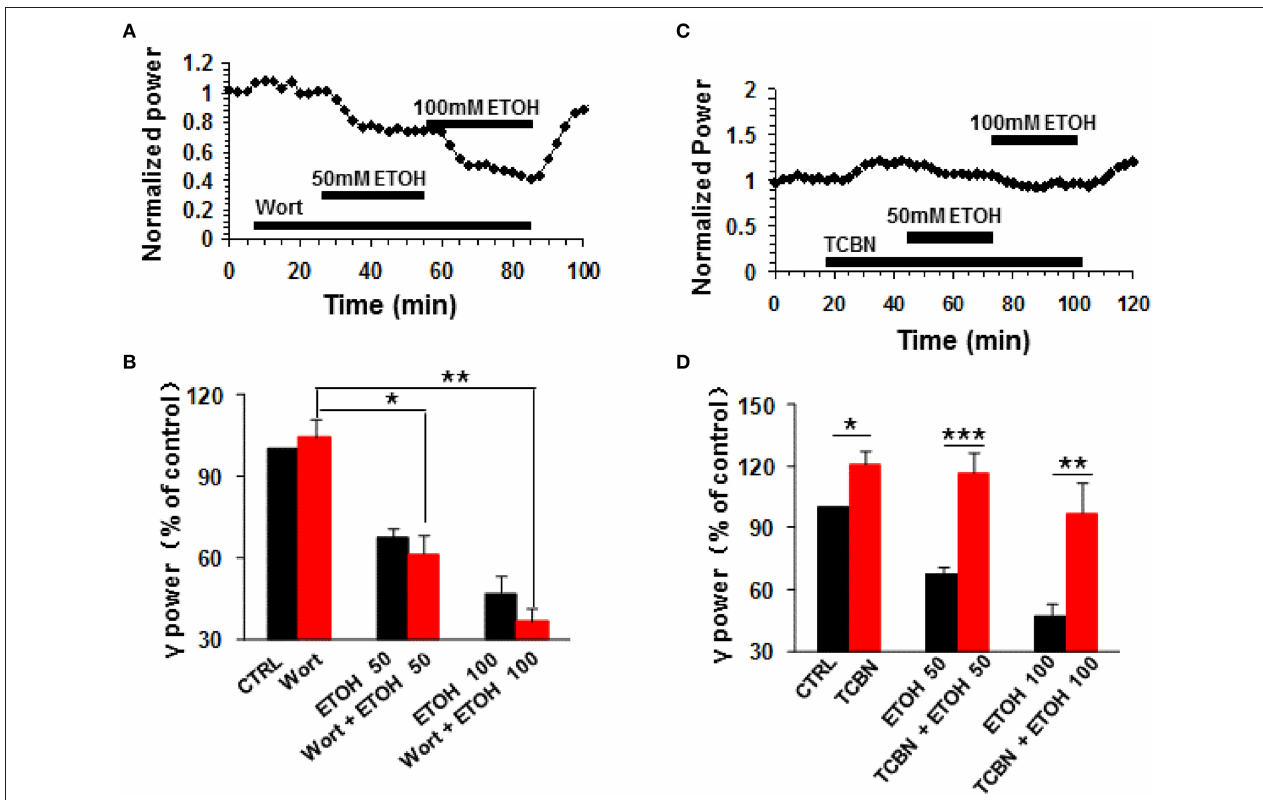
FIGURE 4 | The effects of PI3-kinase and Akt inhibitors on ethanol-induced suppression of γ oscillations. (A) Example of the effect of ethanol on γ power in the presence of the PI3 kinase inhibitor wortmannin (200nM). Details as in Figure 2A . (B) γ power as % of baseline for wortmannin (Wort), 50mM ethanol ( n = 16) and 100mM ethanol ( n = 11) Details as in Figure 2B . * P < 0.05; ** P < 0.01. (C) Example of the effect of ethanol on γ power in the presence of the Akt inhibitor TCBN (5 µ M). Details as in Figure 2A . (D) γ power as % of baseline for TCBN, 50mM ethanol ( n = 9) and 100mM ethanol ( n = 9). Details as in Figure 2B . * P < 0.05; ** P < 0.01; *** P <